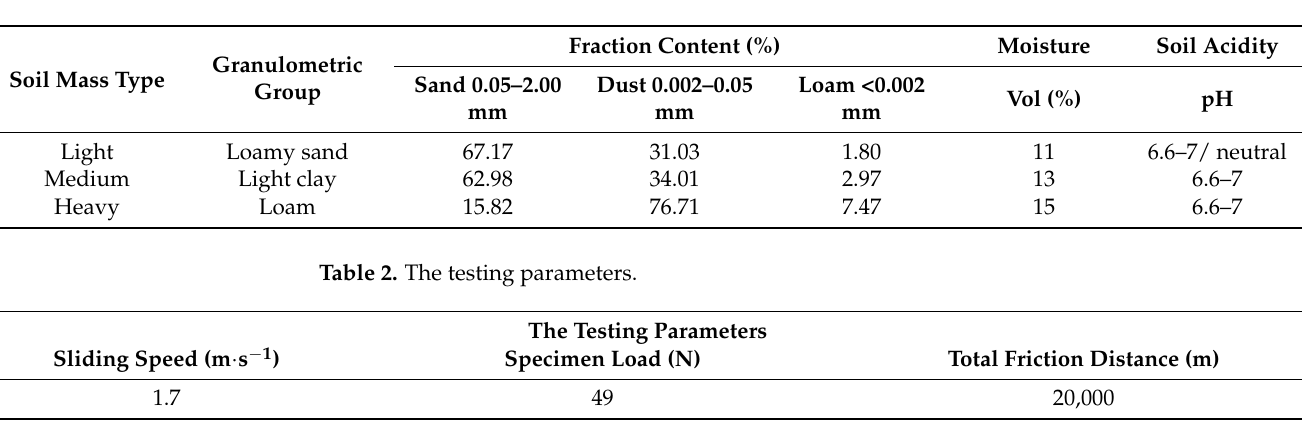
Table 1. Abrasive soil mass characteristics.